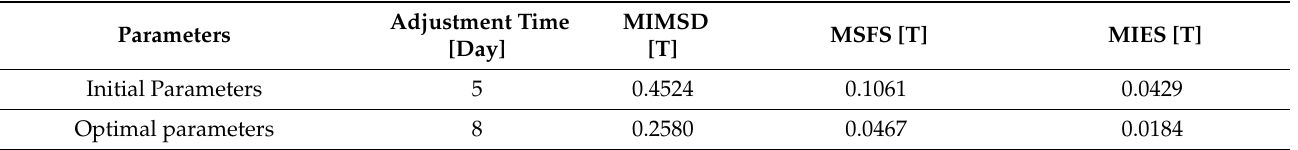
Table 3. Optimization model related experimental parameters